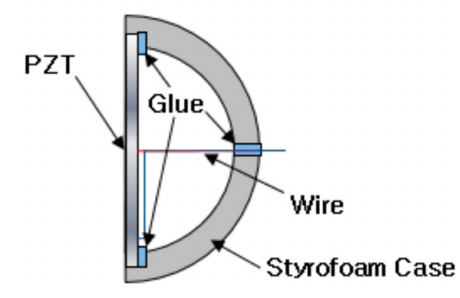
Figure 1. Styrofoam case used to protect the sensor.